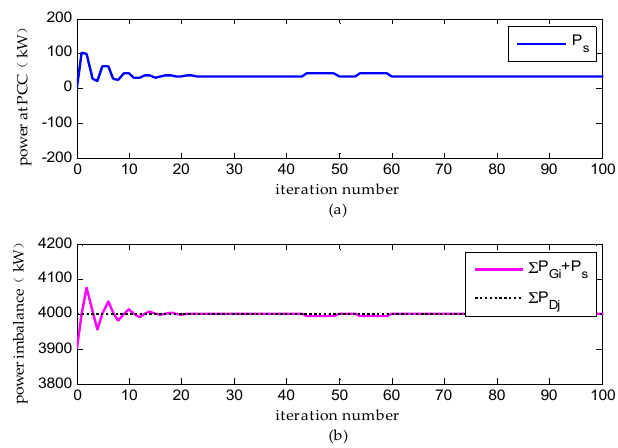
Figure 14. Dispatch results in Scenario F . ( a ) Power output of PV; ( b ) Power output of WG; ( c ) Power output of MGG; and ( d ) Power output of BE.